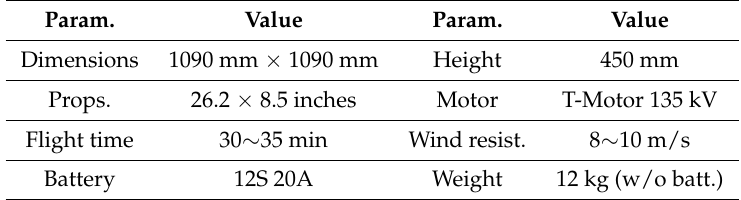
Table 1. Platform